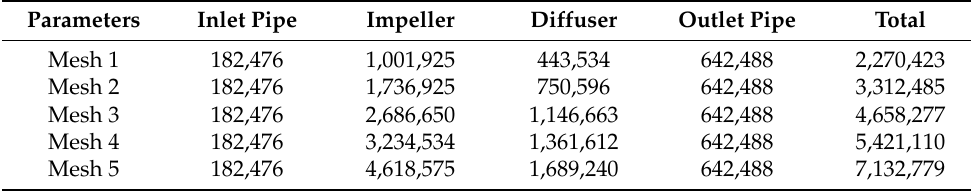
Table 3. Mesh distribution.